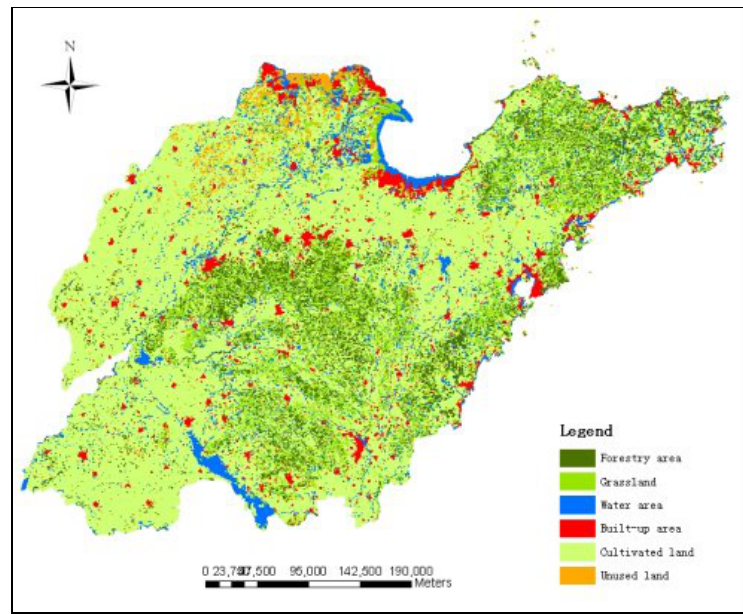
Figure 3. Land use data of Shandong Province, 2002.